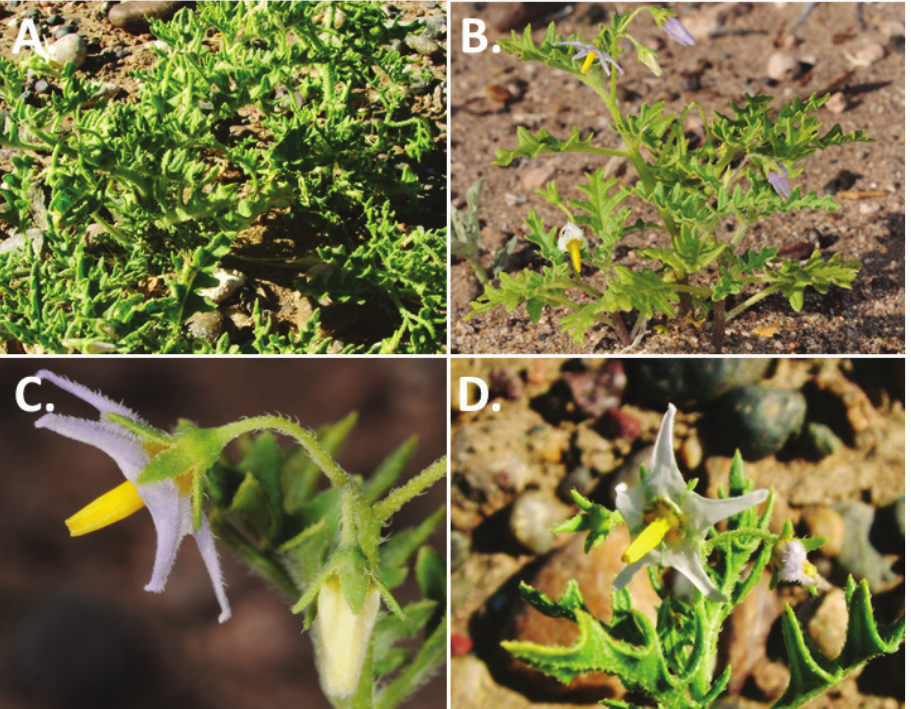
Figure 52. Solanum triflorum Nutt. A Habit B flowering habit C flower and flower bud D flower. ( A, D Barboza et al. 2345 B, C Sérsic 5040 ). Photos by G. Barboza and A. Sérsic (previously published in “PhytoKeys